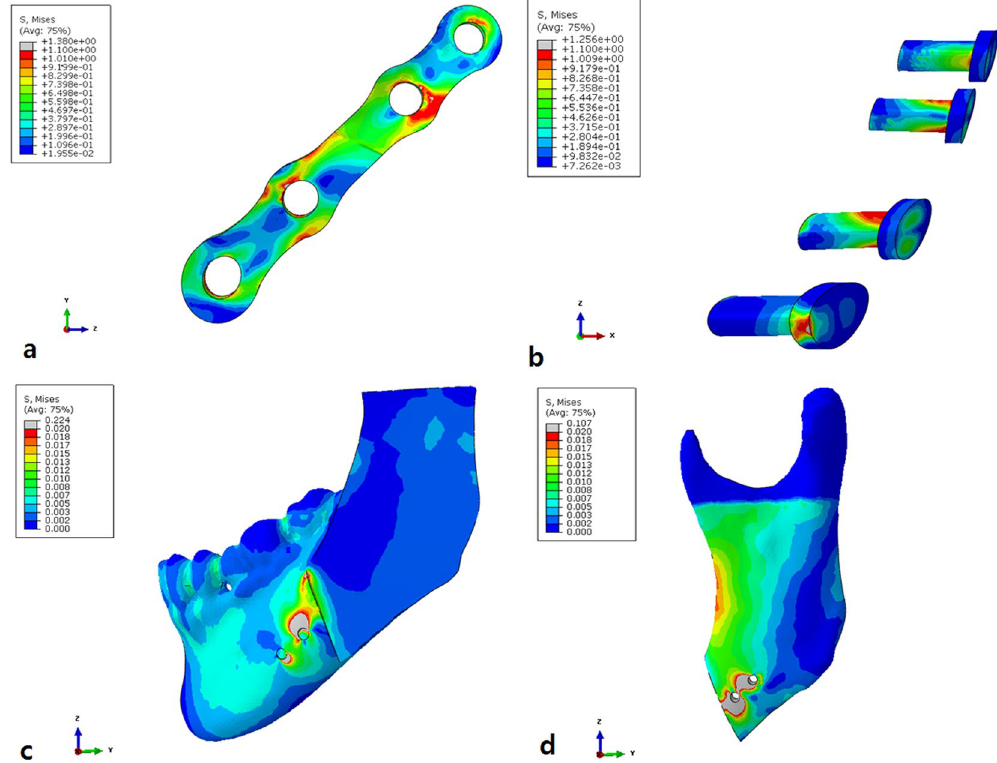
Figure 2. Finite-element model demonstrating stresses in the 4-hole bridge plate model. ( a ) Four-hole bridge plate, ( b ) Four Screws, ( c ) Distal segment (buccal view) and ( d ) Proximal segment (buccal